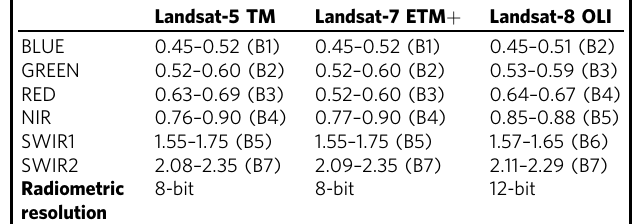
Table 1 Description and wavelength ranges (in micrometres)